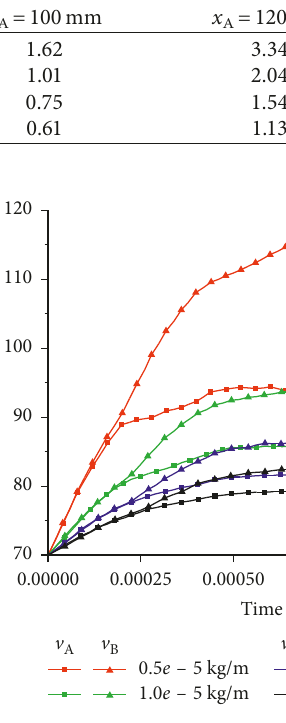
Figure 13: X -velocity of ends A and B of fiber with different linear densities.